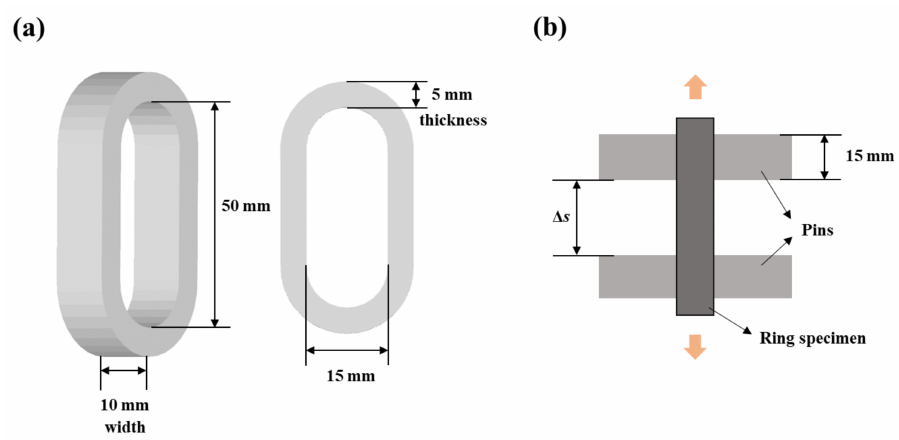
Figure 1. Dimensions of the ring specimen ( a ) and a schematic drawing of the front view of the ring tensile test ( b